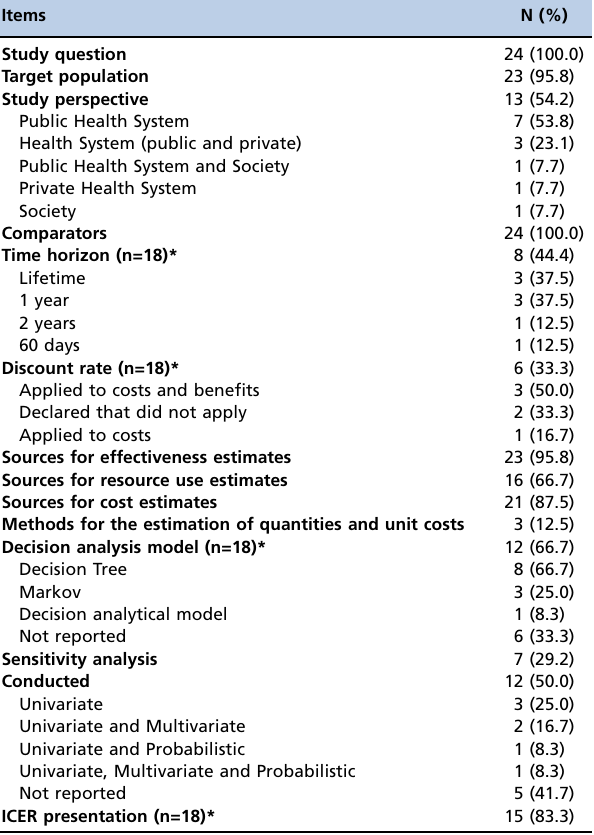
Table 3 - Methodological quality reporting of HEEs related to diagnostic tests conducted in Brazil, 1980-2013 (n = 24).